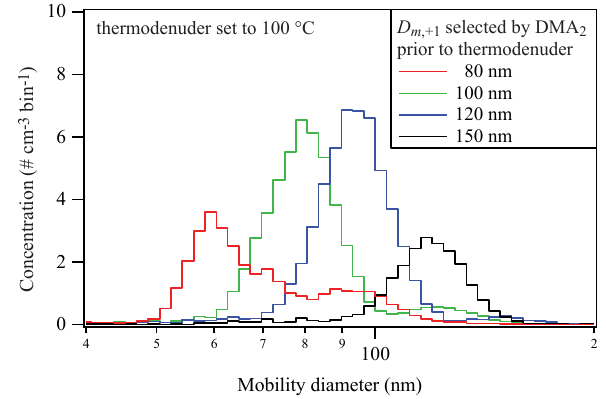
thermodenuder at 60 and 100 ◦ C was studied. The number- 100 ◦ C can be compared to those shown in Fig. 2 for 25 ◦ C,